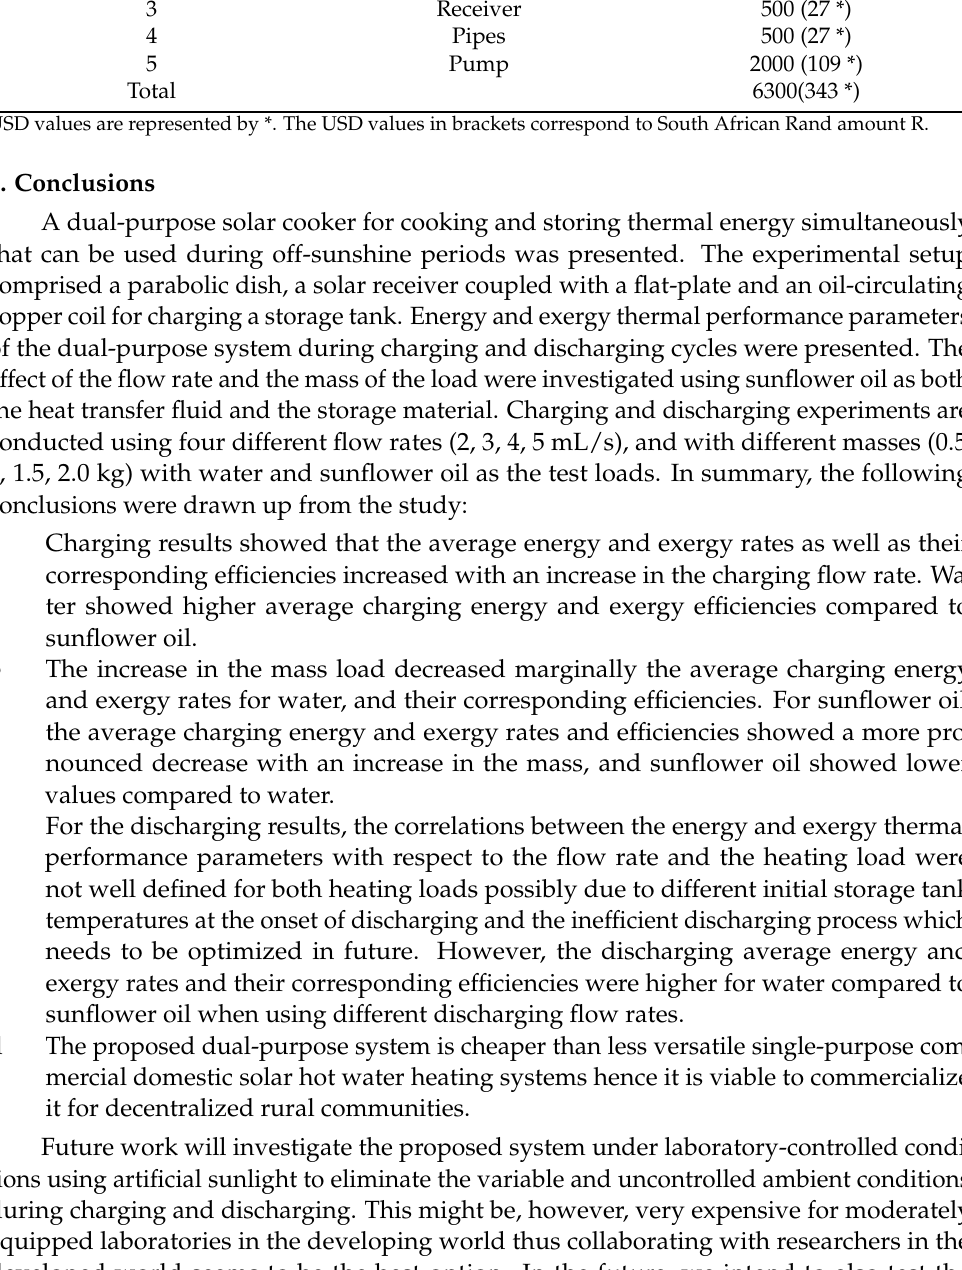
Table 6. Estimated total cost of the combined solar cooking and TES system. Component No Component Description Cost R (USD *) 1 Parabolic Dish 2500 (136 *) Storage Tank Receiver Pipes 500 (27 *) Pump 2000 (109 *) Total 6300(343 *) USD values are represented by *. The USD values in brackets correspond to South African Rand amount